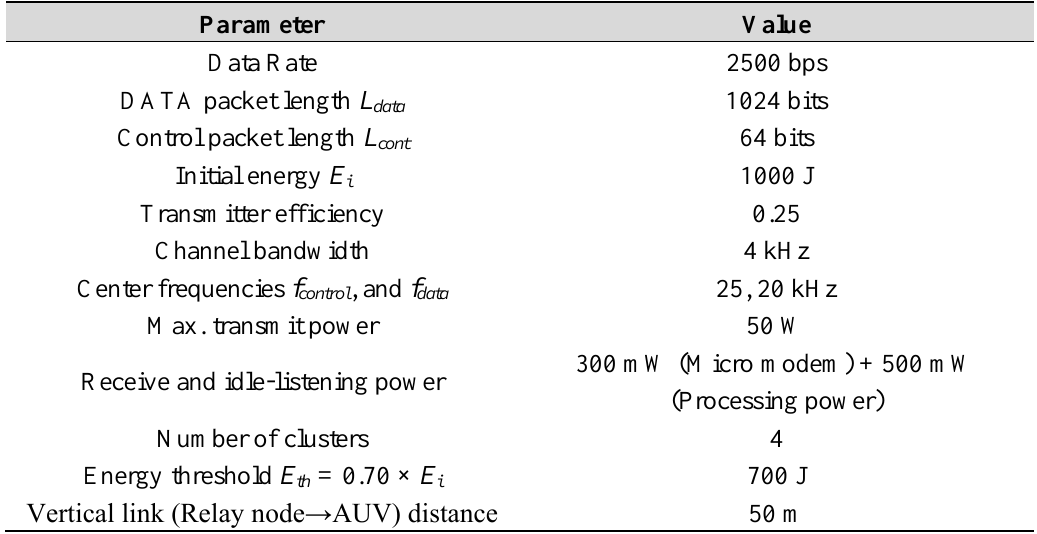
Table 1. Simulation parameters.